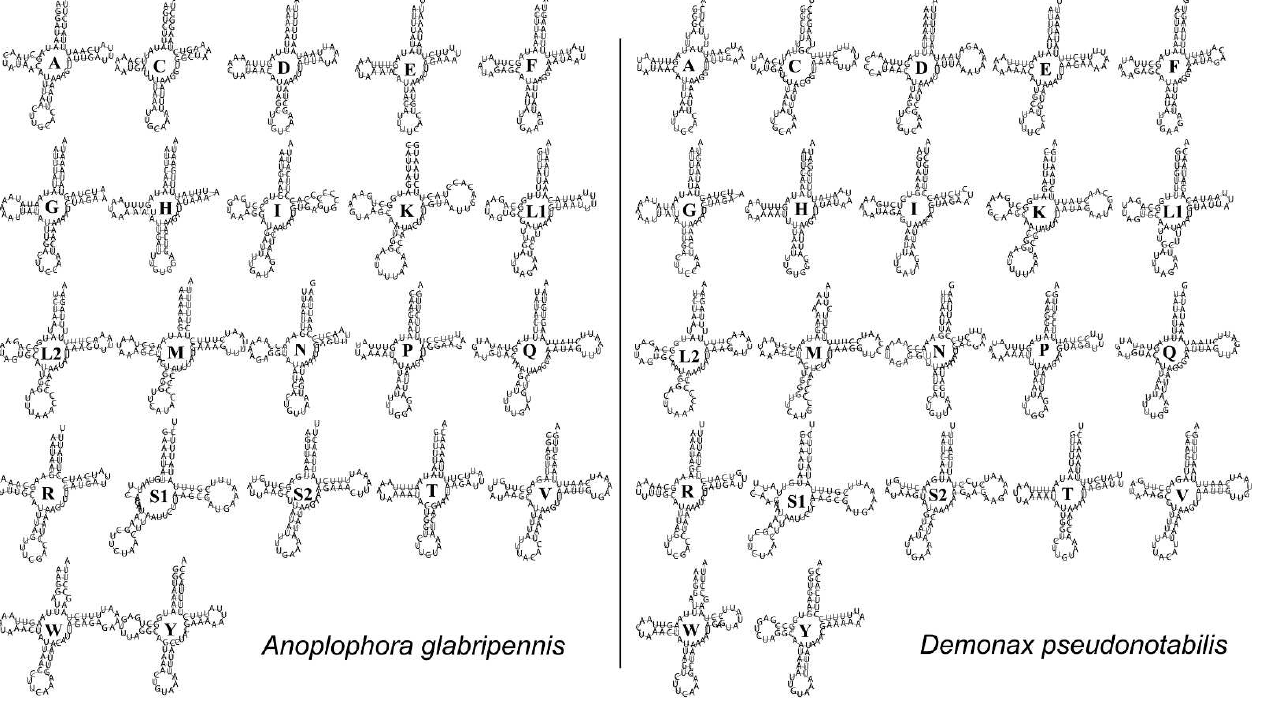
Figure 4. Secondary structures of tRNA genes in the mitogenomes of A. glabripennis and D. pseudonotabilis . The identity of each tRNA gene is represented by the abbreviation of the related amino acid.